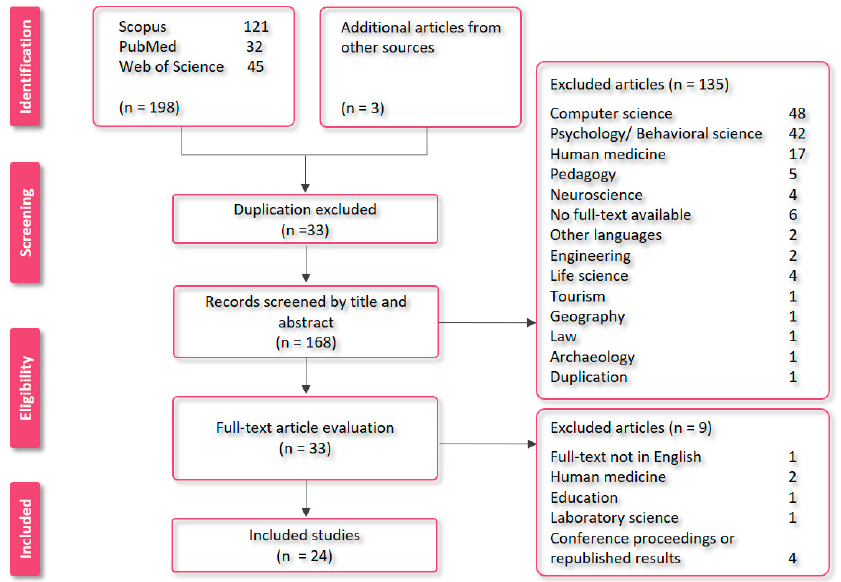
Figure 1. PRISMA flow diagram illustrating literature research, exclusion process, and number of included studies in systematic review.